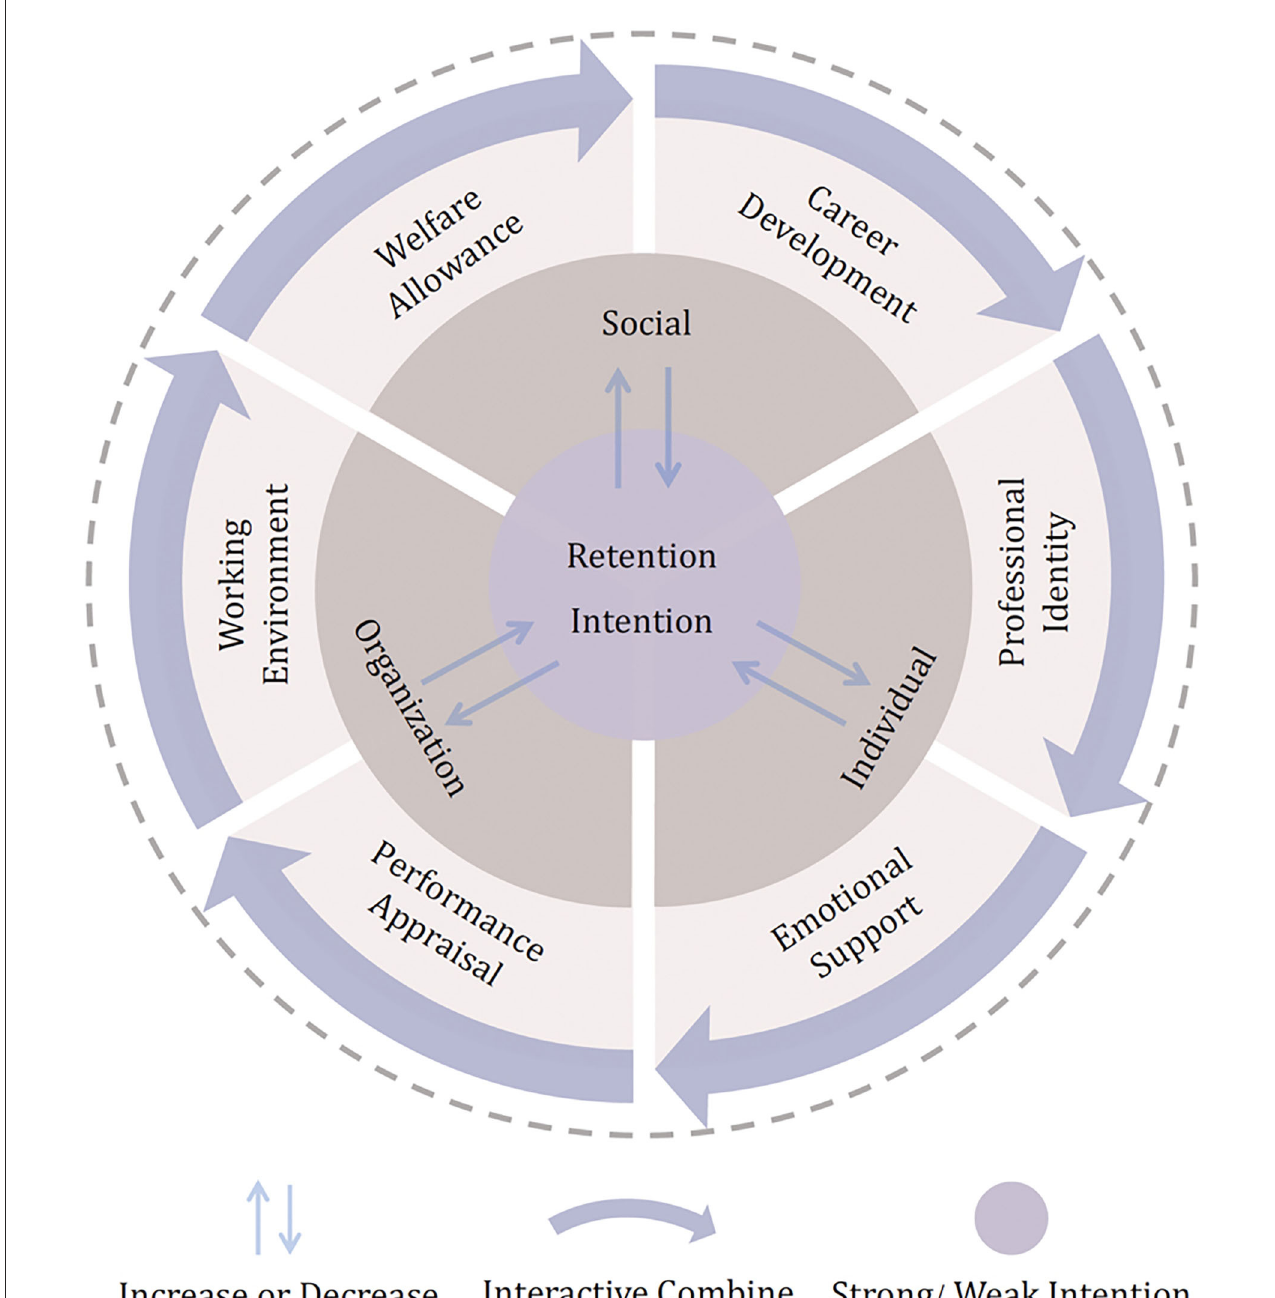
FIGURE1 Factors of CRTs’ turnover theoretical